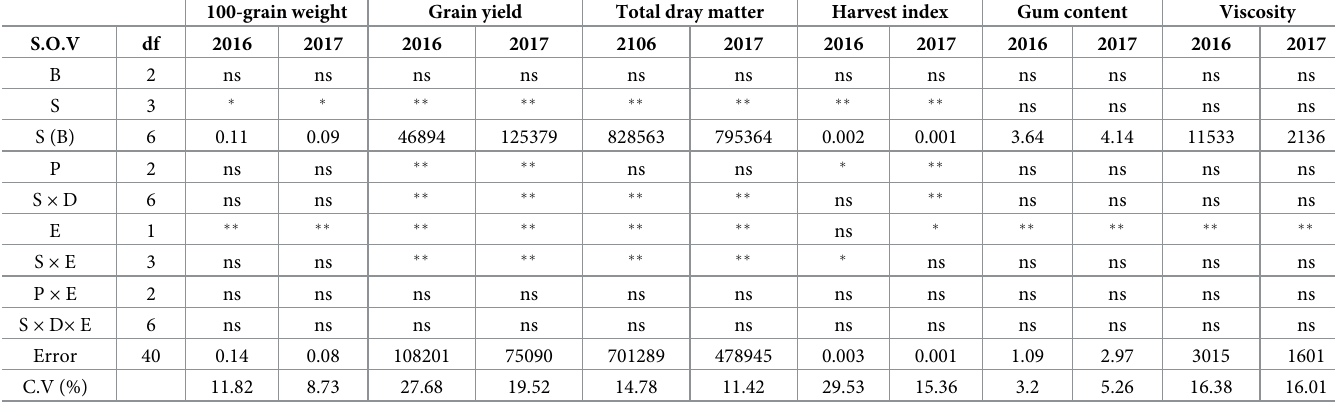
Table 3. Analysis of variance on hundred grain weight, grain yield, total dry matter, harvest index, gum content and viscosity affected by sowing date, plant density and ecotype in 2016 and 2017. 100-grain